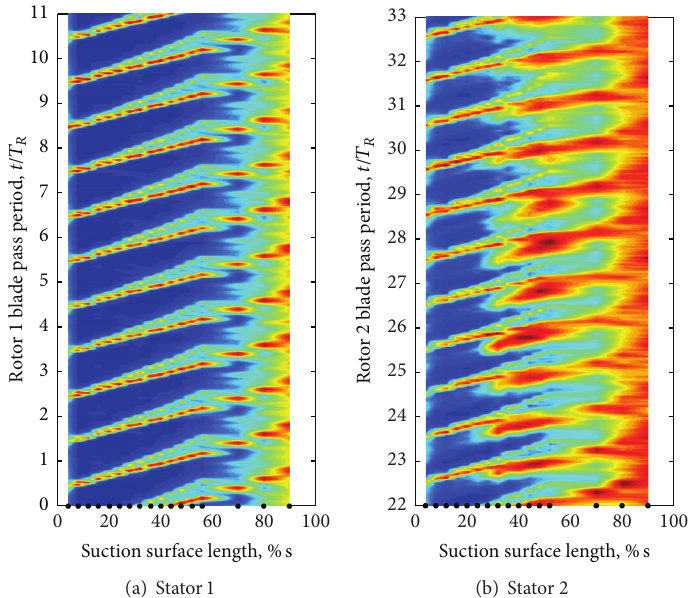
Figure 5: St-diagram of QWSS RMS for (a) Stator 1 and (b) Stator 2, at mid-span for peak efficiency